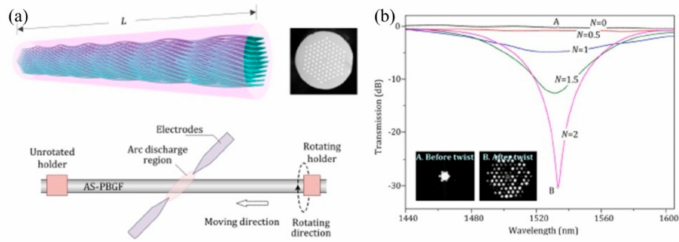
Figure 22. ( a ) Schematic diagrams and ( b ) transmission spectra of HLPFG in all-solid PBF using the arc discharge heating techniques